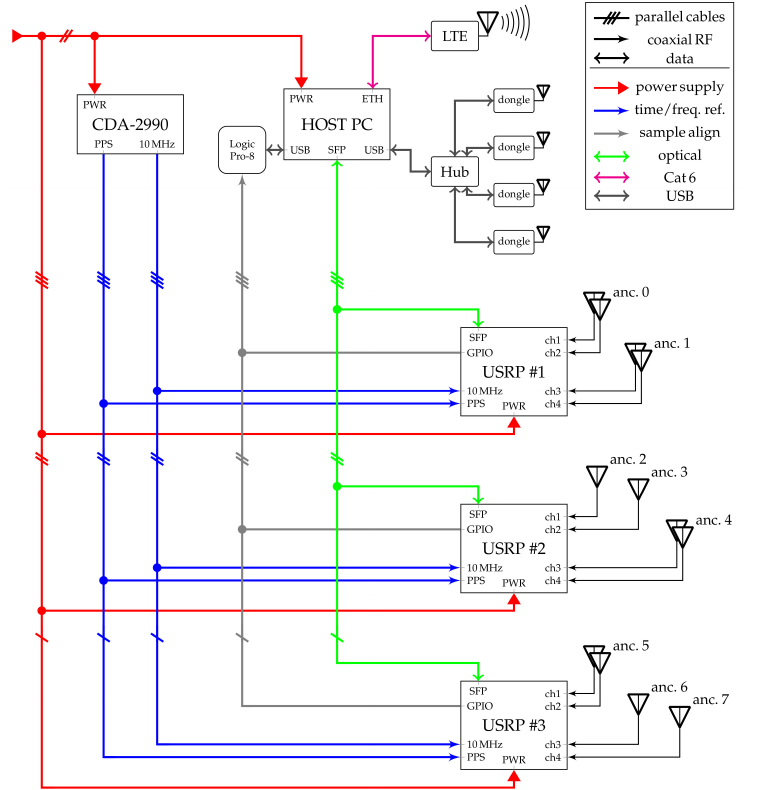
Figure 5. Block diagram of the full measurement setup. The USB dongles used to communicate with the target nodes are connected via a USB hub. The power supply uses a power cord with 230V AC. All RF cables are 50 Ω coaxial cables with SMA connectors. The connections indicated as parallel use distinct cables for each USRP radio platform, connected to distinct ports at the host setup, e.g., three SMA connectors for the 10MHz reference, three SFP fiber connectors,